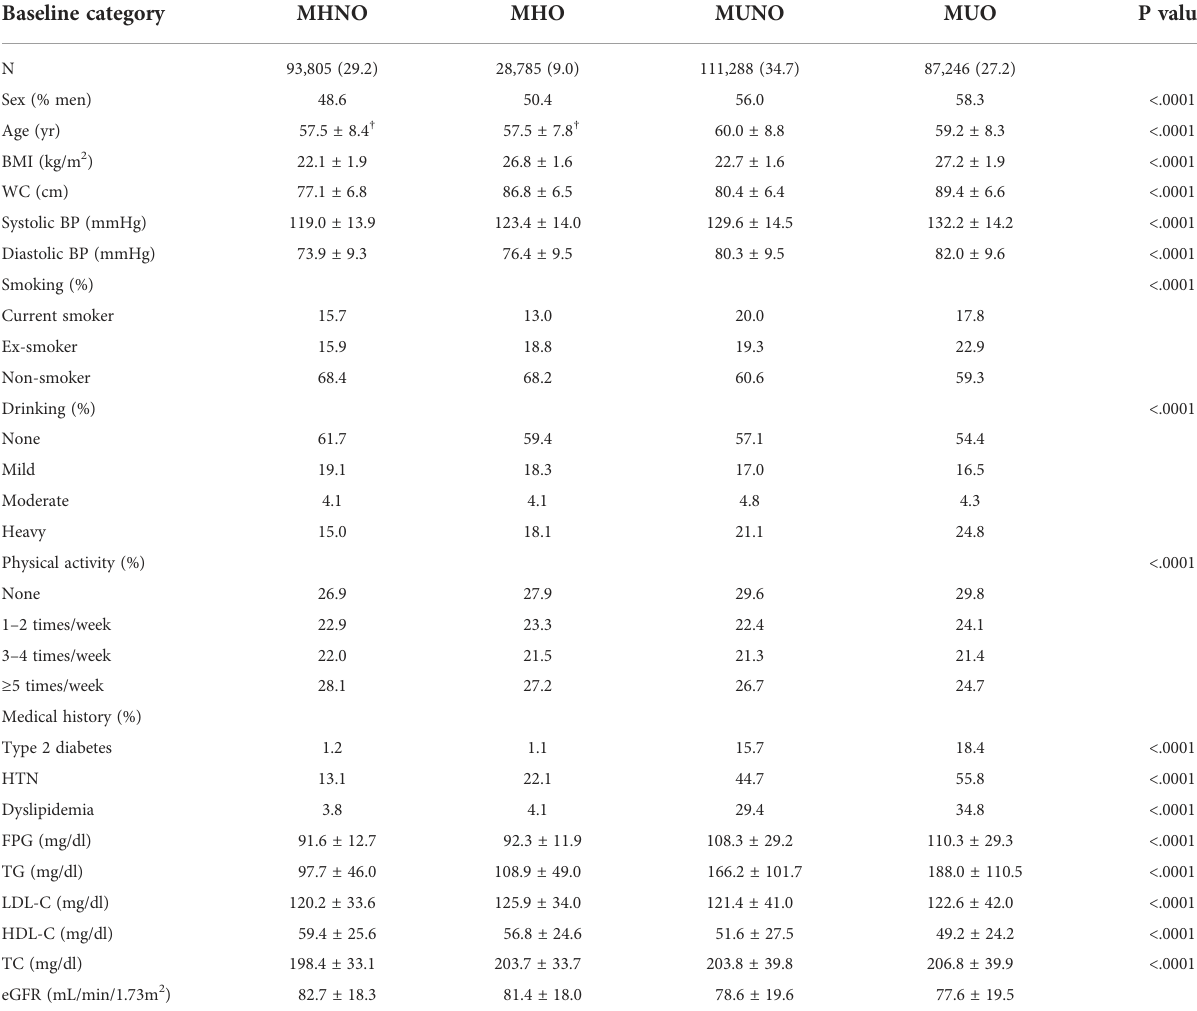
TABLE 1 Characteristics of the study participants according to baseline metabolic health and obesity status. Baseline